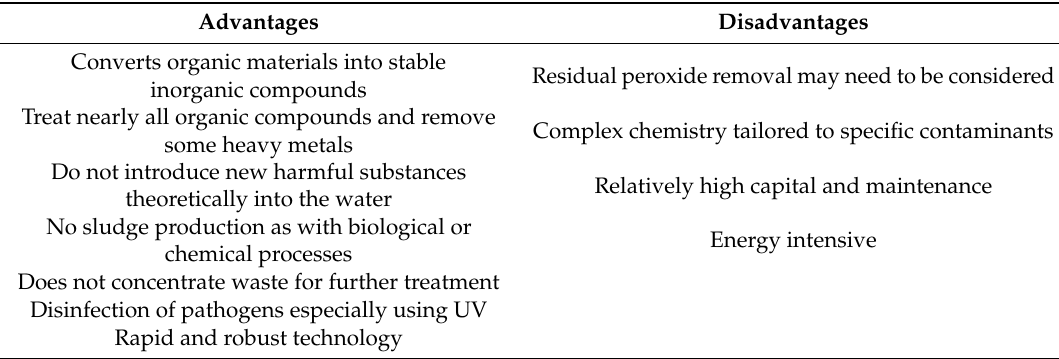
Table 4. Advantages and Disadvantages of AOPs in WWTPs.